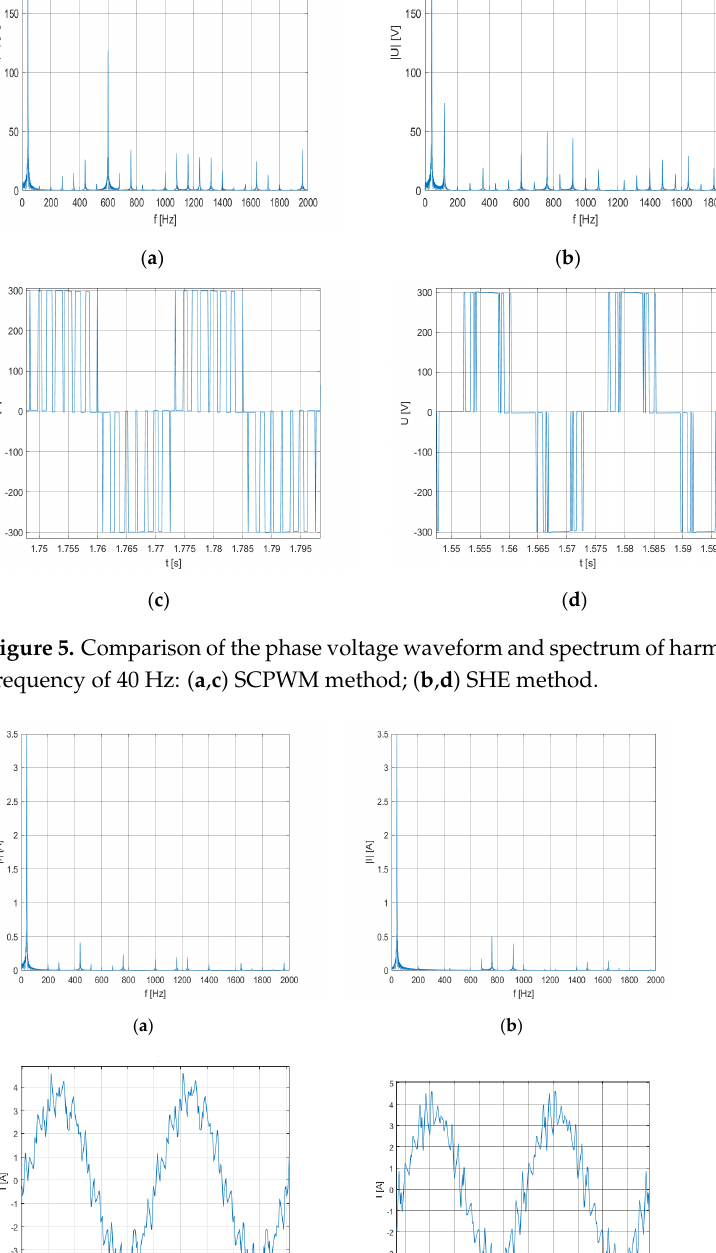
frequency of 40 Hz: ( a , c ) SCPWM method; ( b , d ) SHE method.